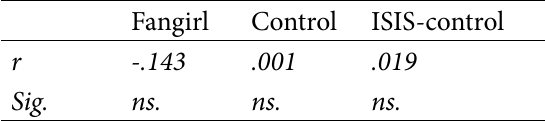
Table 4. Pearson correlation of number of words in concepts with frequency of concepts in Fangirl and control tweet collections